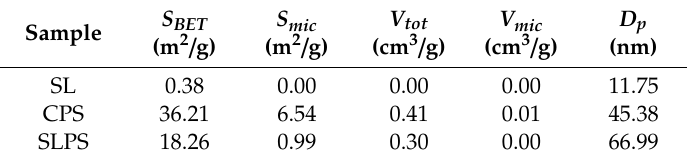
Table 1. Porous structure parameters of